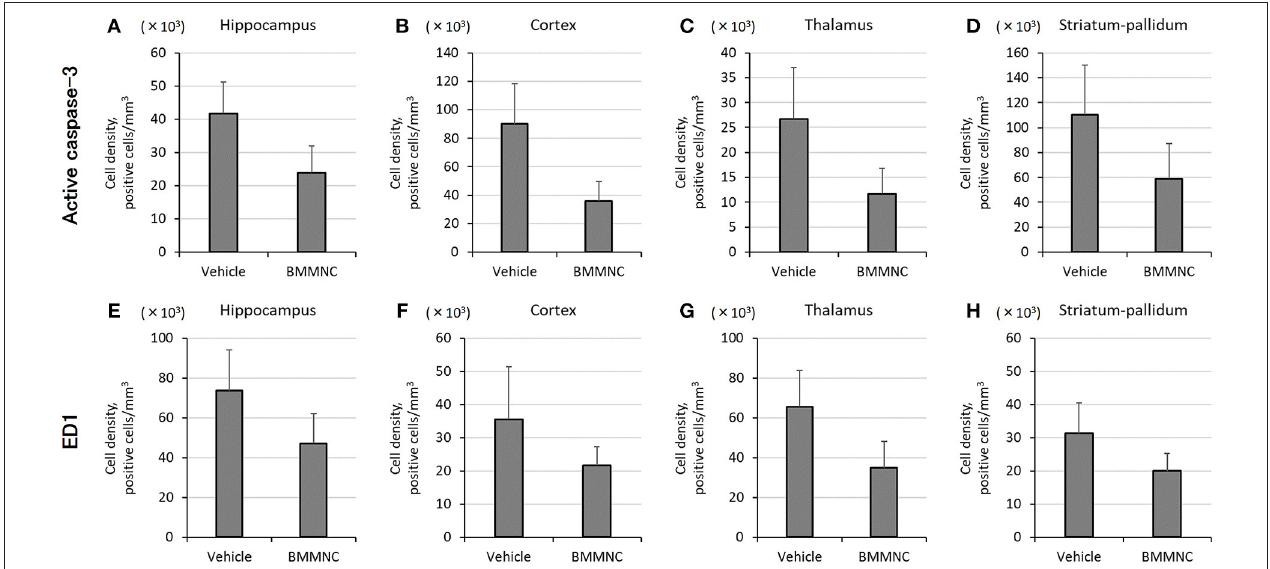
FIGURE 5 | Effect of BMMNC on the expression of acute injury biomarkers for apoptosis [active caspase-3, (A–D) ] and activated microglia/macrophage [ED1, (E–H) ]. The number of marker-positive cells was counted in the hippocampus, cortex, thalamus, and striatum-pallidum. The number of active caspase-3-positive cells for the sum of the four parts was significantly lower in the BMMNC group ( n = 10) than in the vehicle group [ n = 9, (A–D) , two-way ANOVA]. The number of ED1-positive cells for the sum of the four parts was also significantly lower in the BMMNC group [ (E–H) , two-way ANOVA]. Data are presented as mean ± standard error of the mean.